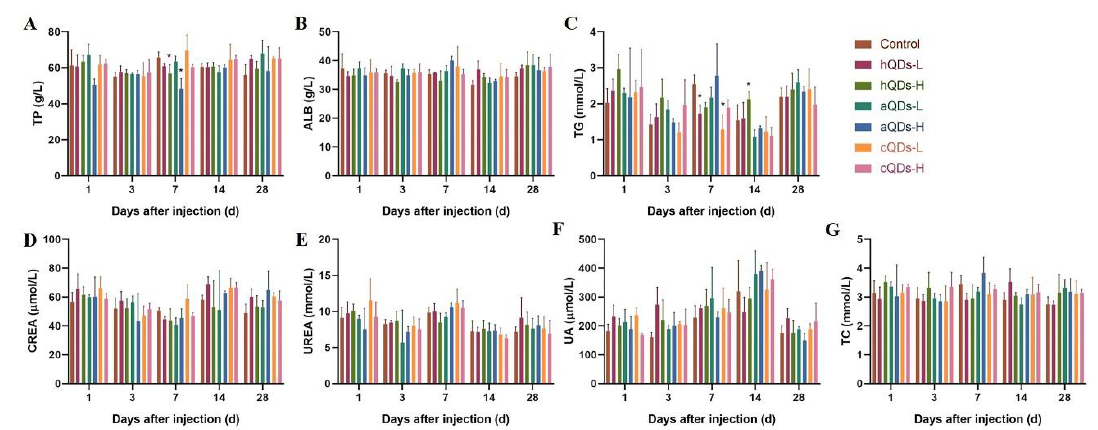
Figure 4. InP/ZnS QDs-induced changes in biochemical parameters of the serum of mice administered with 25 mg/kg BW QDs (H) or 2.5 mg/kg BW QDs (L). ( A ) TP level. ( B ) ALB level. ( C ) TG level. ( D ) CREA level. ( E ) UREA level. ( F ) UA level. ( G ) TC level. (*Significantly different compared to control group at the same sampling time, p < 0.05).